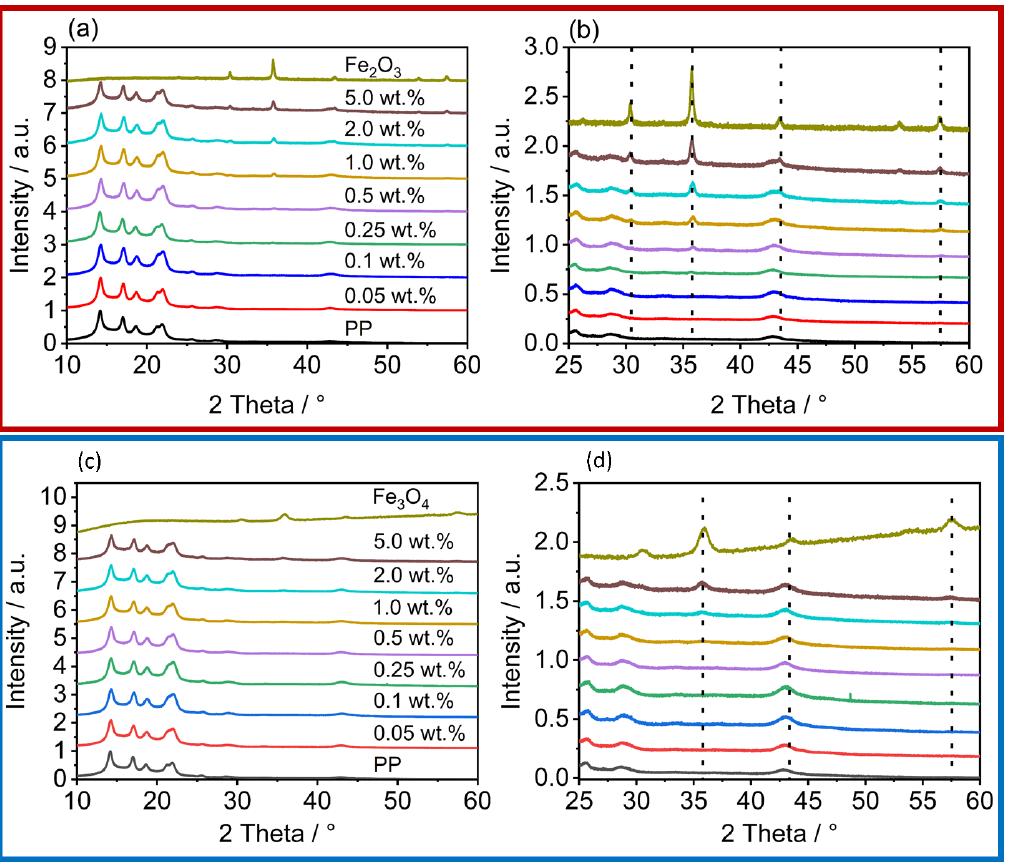
Figure 7. XRD of the iron oxides, the unfunctionalized PP, and the coated powders; the red box contains the diffractograms of the γ -Fe 2 O 3 coated powders, the blue box the diffractograms of the powders with Fe 3 O 4 . ( a , c ) shows an overview over the measured area; ( b , d ) zooms inside the area, where the increase of the iron oxide reflexes are